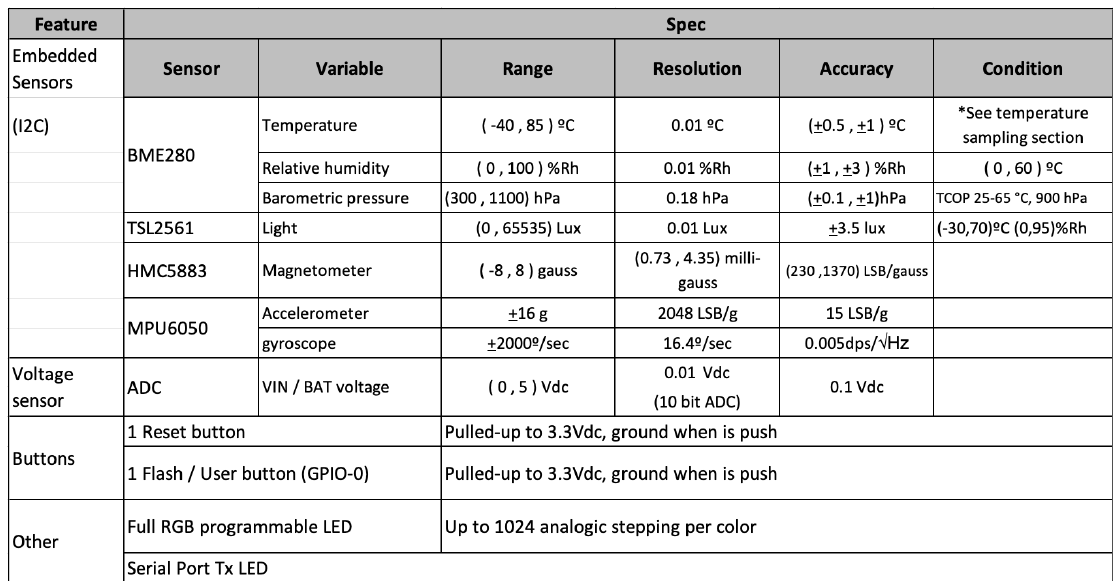
Figure 18. Integrated sensors in